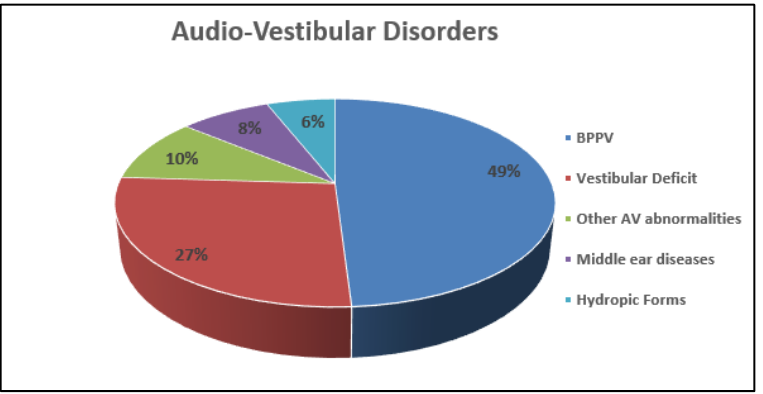
Figure 5. Overall (percentage %) distribution of different Audio-Vestibular (AV) disorders.